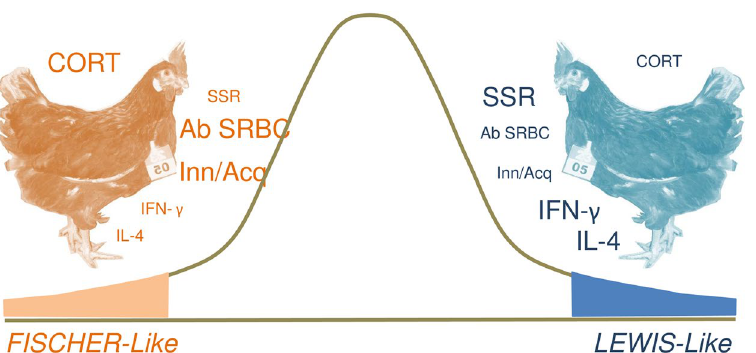
Figure 5. Schematic conceptual representation of INPs in Gallus gallus . The variables determining the existence of INPs are represented around each bird. The size of the variable indicates if the animals show high or low response in each of the parameters. SSR: skin-swelling response to PHA-P; Ab SRBC: antibody response against SRBC; Inn/Acq: innate/acquired leukocyte ratio; level of expression of pro-inflammatory (IFN- γ ) and anti- inflammatory (IL-4) mediators. ‘FISCHER-like’ hens with high CORT concentration also manifest high Innate/ Acquired and Ab SRBC, but low SSR, IFN- γ and IL-4 levels. ‘LEWIS-like’ counterparts have low CORT as well as low Innate/Acquired and AB SRBC responses, but high SSR, as well as INE mediators (IFN- γ and IL-4)